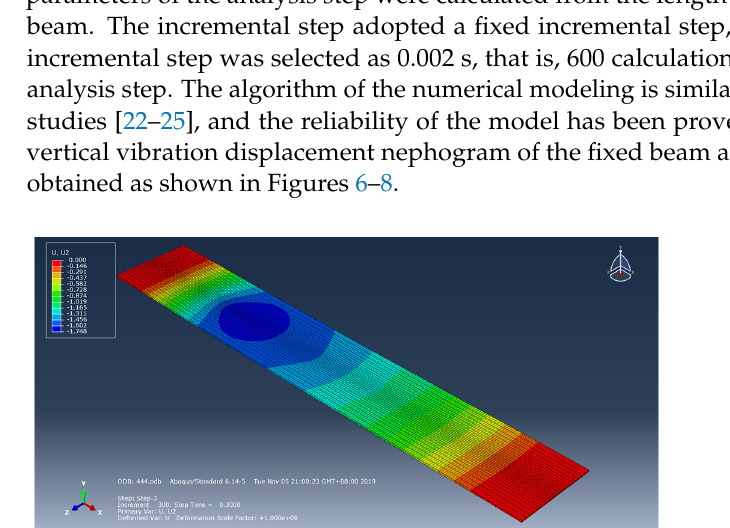
Figure 5. Fixed-beam model. ( a ) The boundary conditions. ( b ) The load conditions.